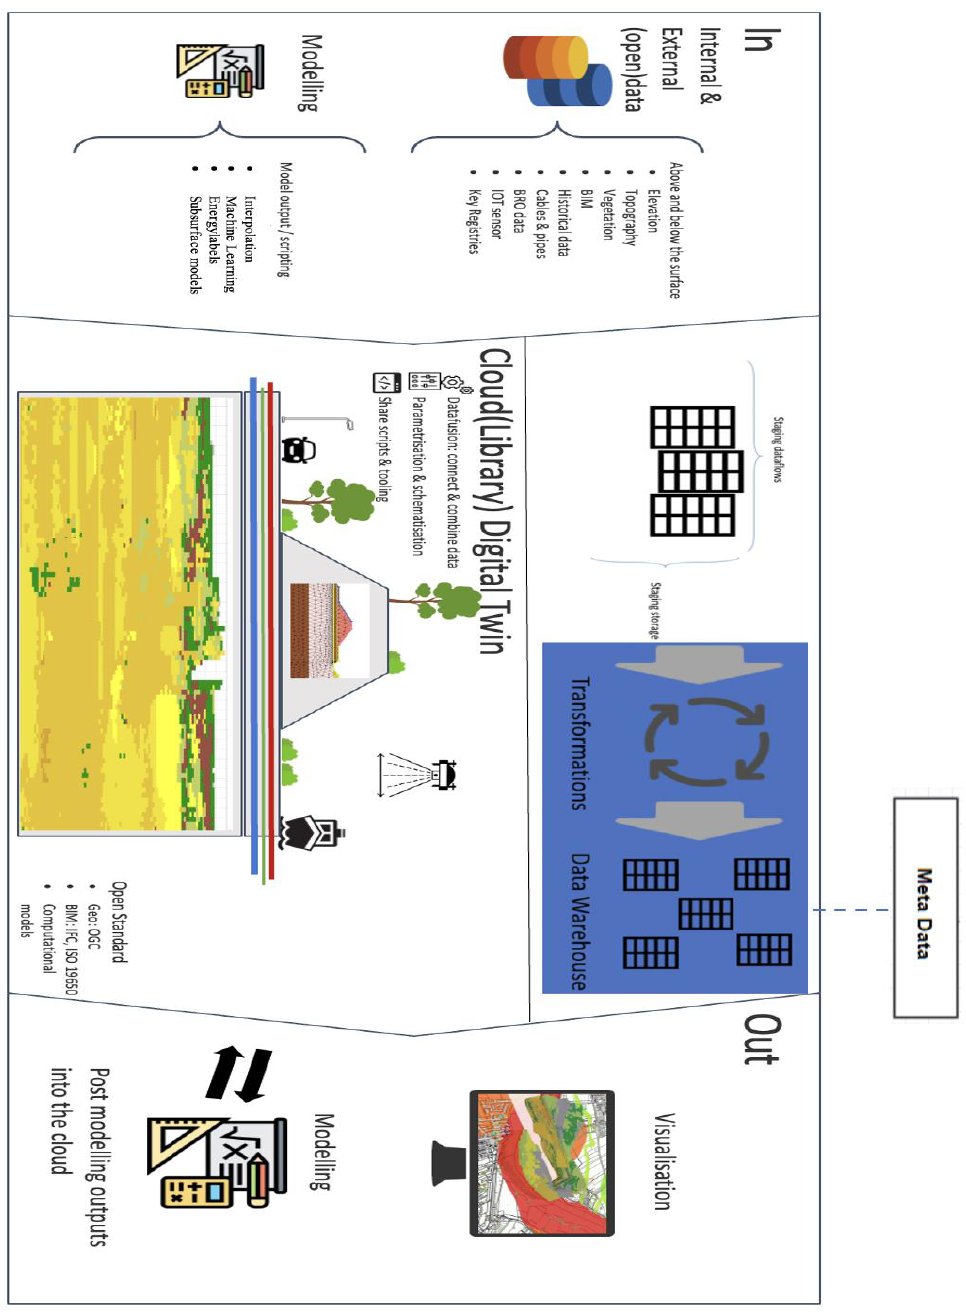
Figure 3. Sketch of an urban data warehouse. Source: authors’ own